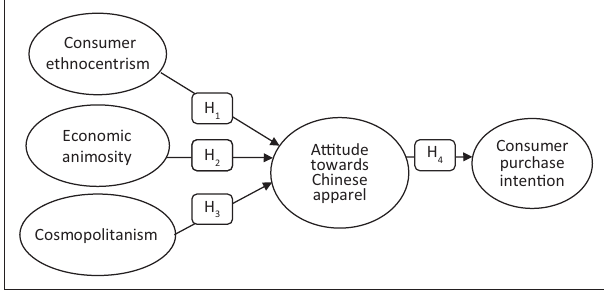
FIGURE 1: Research model